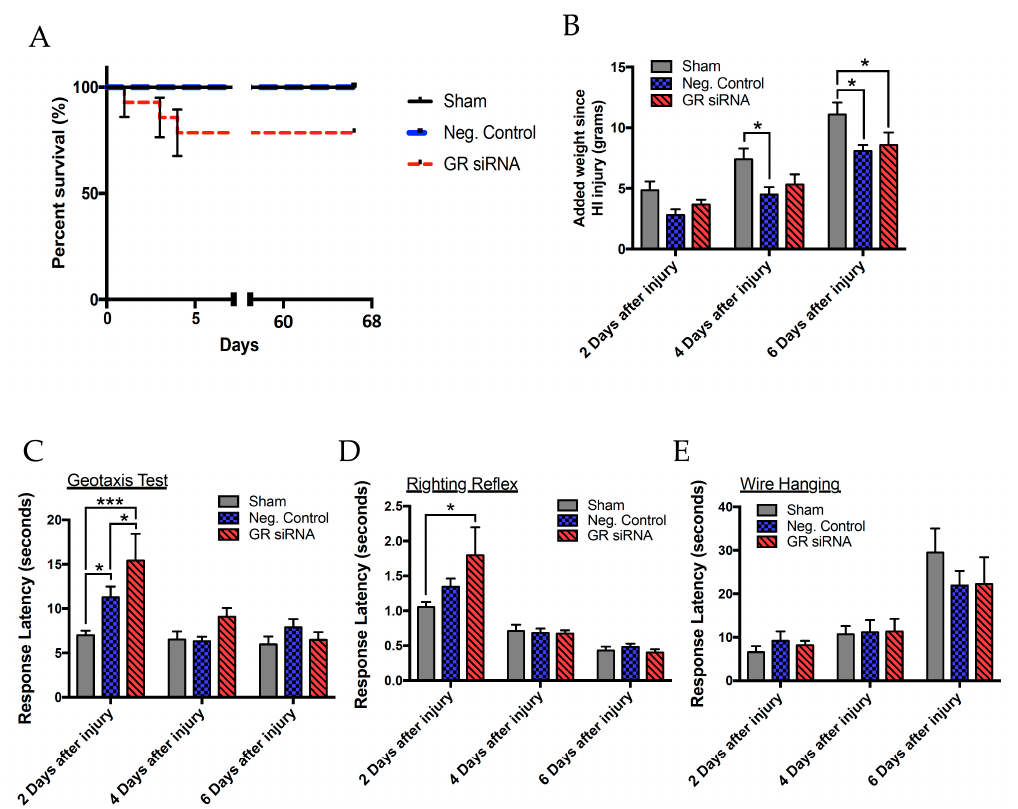
Figure 4. Repression of GR worsens short-term neurobehavioral deficits in the neonatal male rat with mild HI injury. The neonatal male rats received GR siRNA (100 pmol) or negative control (100 pmol) by ICV injection 48 h before HI-injury (8% O 2 ; 60 min). The sham group did not undergo HI-injury treatment. The short-term neurobehavioral assessment was taken two, four, and six days after HI insult. ( A ) Mortality rate with Groups: negative control without injury (sham); ( n = 12) versus negative control with HI injury ( n = 13) versus GR siRNA ( n = 14) with HI injury. Subsequent weight and behavioral studies do not include animals that did not survive. ( B ) Weight added since HI injury, ( C ) geotaxis test, ( D ) righting reflex, and the ( E ) wire hanging test were evaluated accordingly. Groups for weight and short-term behavior were negative control without injury (sham); ( n = 12) versus negative control with HI injury ( n = 13) versus GR siRNA ( n = 11) with HI injury. Data are means ± SEM, * p < 0.05, *** p < 0.0001.